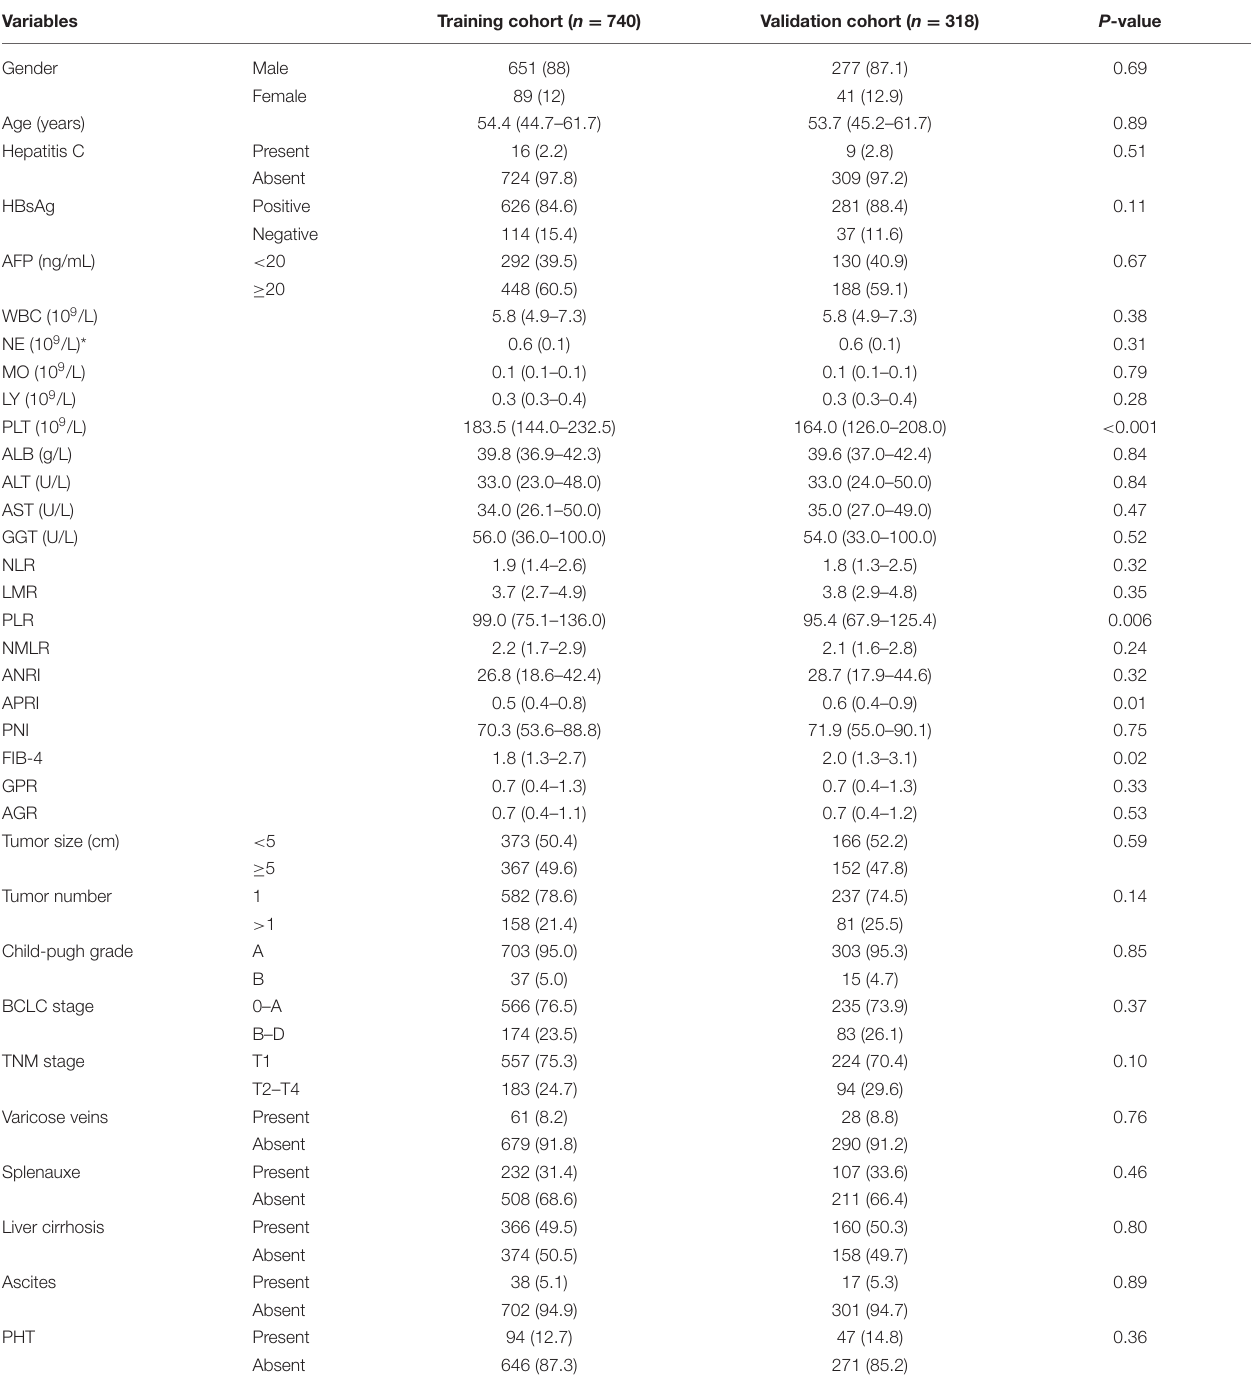
TABLE 1 | Comparison of patients’ characteristics in the training and validation cohorts.